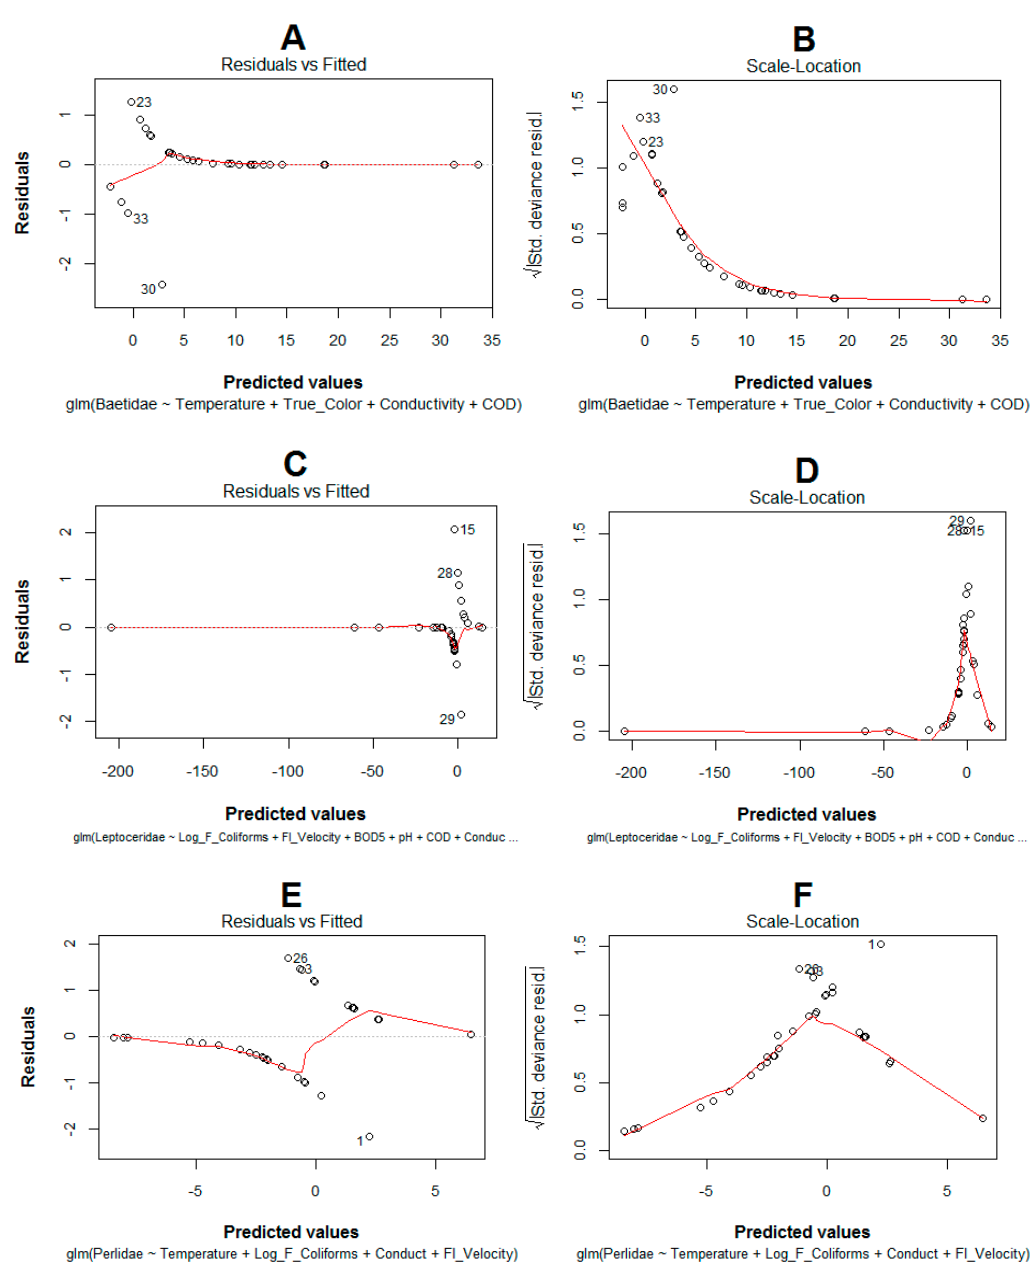
Figure A12. Plots of Residual vs. Fitted ( A ) Baetidae ; ( C ) Leptoceridae ; ( E ) Perlidae and plots of Scale-Location of ( B ) Baetidae ; ( D ) Leptocerida and ( F ) Perlidae .